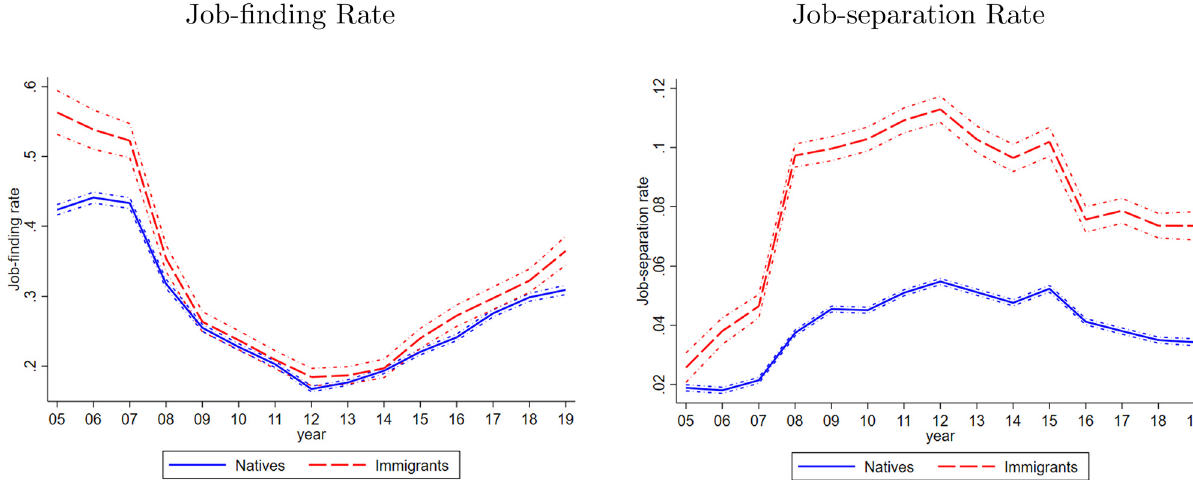
Figure 5: Conditional labour market transitions by nationality. Note: The fi gure plots the residuals ( evaluated at the average at means of other covariates ) obtained from the estimation of equations ( 3 ) and ( 4 ) using a linear probability model. Both regressions include controls for education, potential experience, marital status, age, gender, region of residence, sector of activity, occupation, type of contract ( permanent or temporary ) , type of job ( full or partial time ) , tenure and year dummies. Equations ( 3 ) and ( 4 ) are estimated using 263,938 and 2,057,896 observations, respectively. The dashes lines report the 95 percent con fi dence interval on the prediction. Source: Spanish Labour Force Survey - Flows ( 2005 – 2019 )